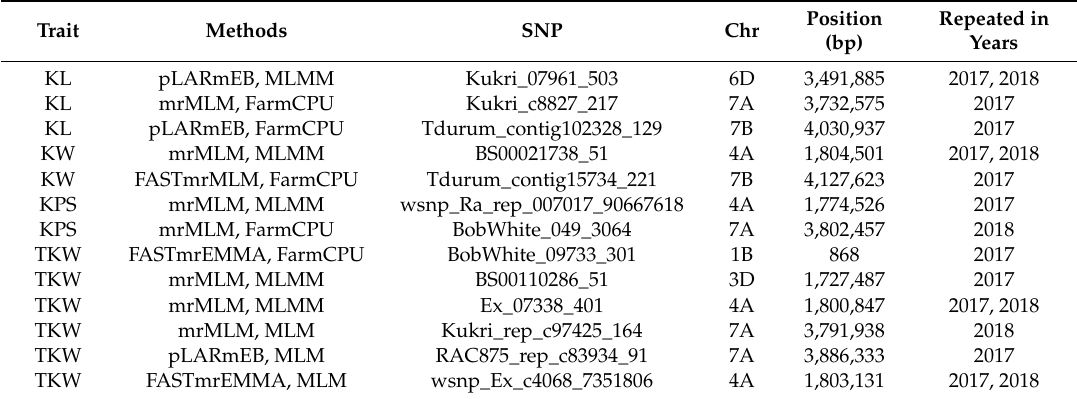
Table 2. Common SNPs simultaneously co-detected by multi-locus and single-locus GWAS methods for the kernel length, kernel width, kernels per spike, and the thousand kernel